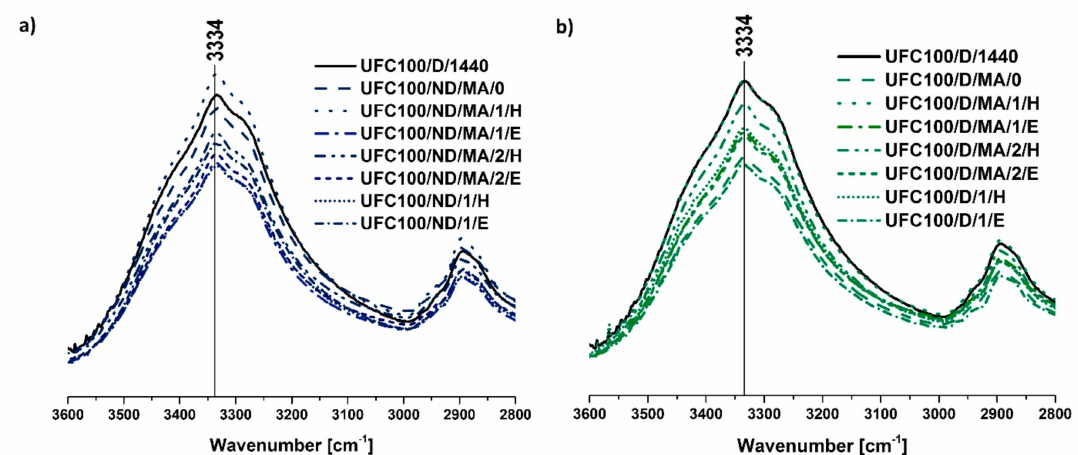
Figure 5. Comparison of the amount of water absorbed by modified cellulose fibers (3334 cm − 1 ): ( a ) UFC100 not dried before the MA treatment, ( b ) UFC100 dried before the MA treatment.